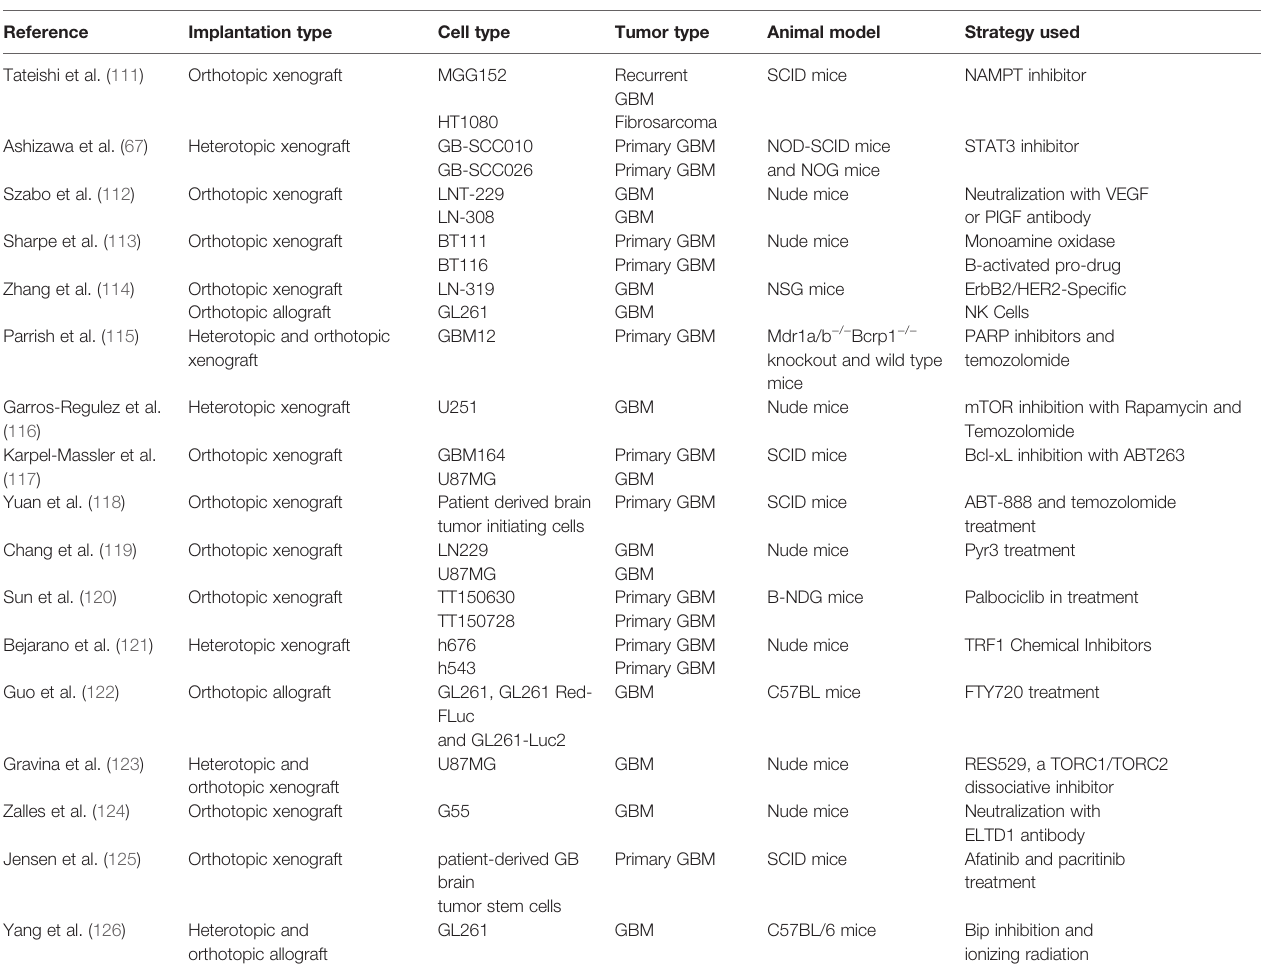
TABLE 2 | Current trends in mouse xenografts and